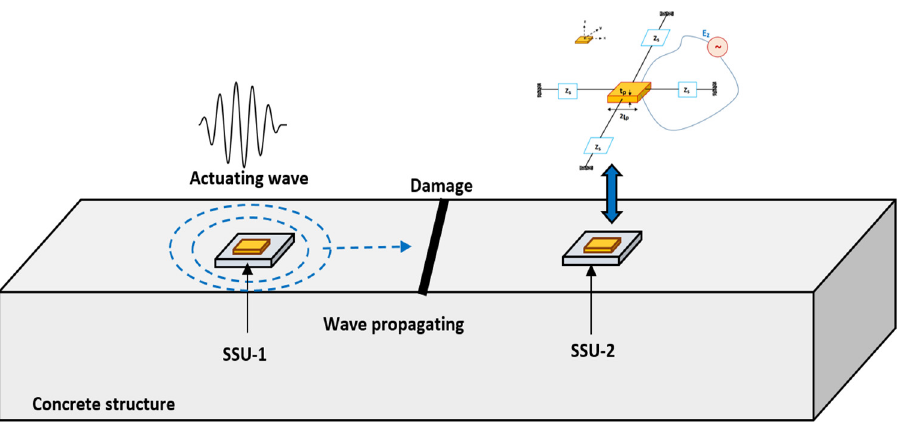
Figure 20. Schematic representation of the combined EMI-WP technique for damage detection in concrete structure utilizing two SSUs.